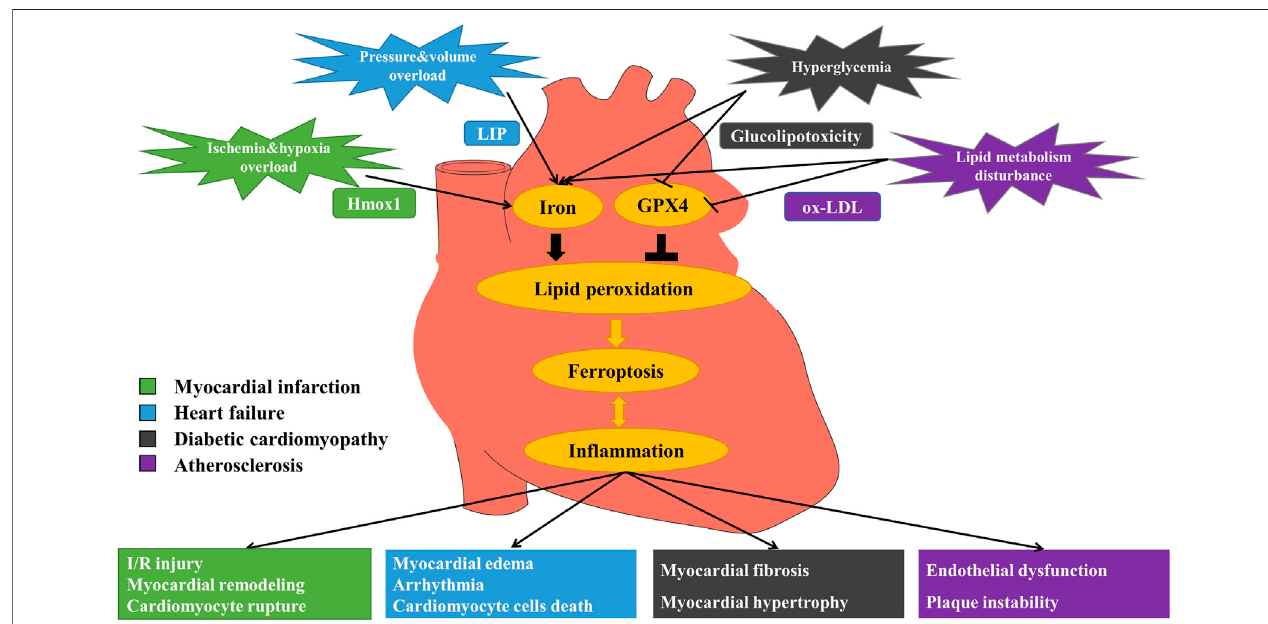
FIGURE 1 | Mechanism of ferroptosis in myocardial infarction (MI), heart failure (HF), diabetic cardiomyopathy (DCM) and atherosclerosis (AS). MI: Under the stimulationofischemiaandhypoxia,excessivefreeironreleasesviaup-regulationofhemeoxygenase1(Hmox1),promotingferroptosisandeventuallycausingI/Rinjury, myocardial remodeling and myocardial cell rupture. HF: Stimulated by pressure and volume overload, labile iron pool (LIP) formation increases, leading to iron overload andtheoccurrenceofferroptosis,andthencausingmyocardialedema,arrhythmiaandcardiomyocytecelldeath.DCM:Inthecircumstanceofhyperglycemia,free iron increases and glucolipotoxicityinduces ferroptosis, triggeringmyocardial fi brosis, and myocardial hypertrophy. AS:Whenthereexists lipidmetabolismdisturbance, ironoverloadandoxidizedlow-densitylipoprotein(ox-LDL)inducelipidperoxidationthattriggersferroptosis, fi nallycausingendothelialdysfunctionandplaqueinstability.